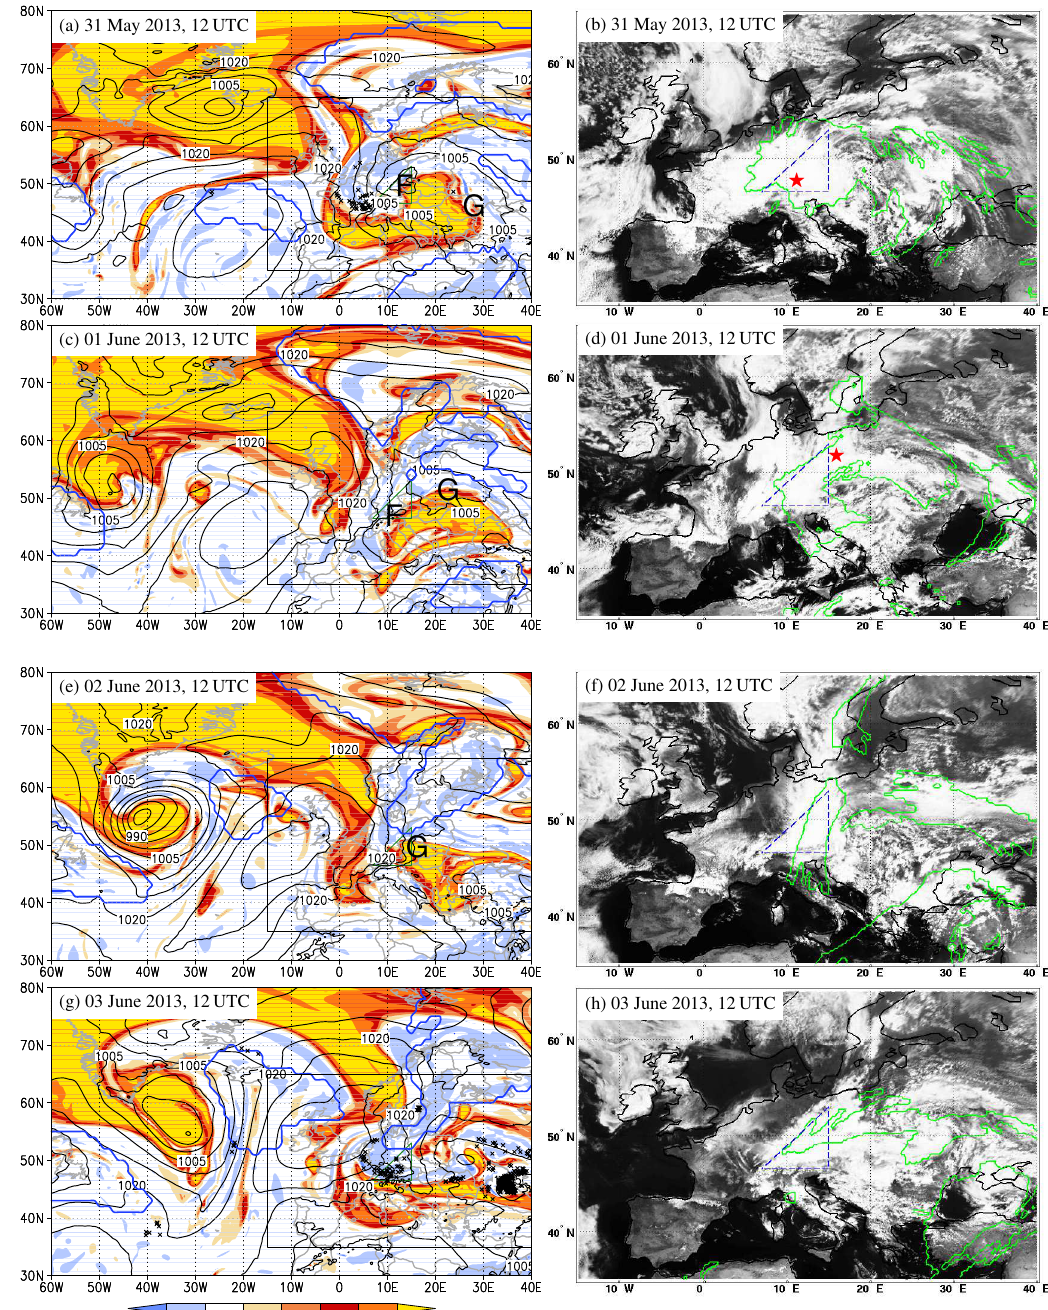
Figure 5. Left: PV at 320K (shaded in PVU), mean sea level pressure (black every 5hPa), outline of identified blockings (blue contour), and in (a–g) every 10th WCB trajectory intersection point with the layer 320K ± 2.5K. Only these WCBs are considered that contribute to the flooding event. The labels F and G mark the position of Frederik and Günther, respectively. Right: MSG-SEVIRI VIS 0.56–0.71µm satellite imagery zoomed over Europe (see box in left panels) and regions with precipitation from WCBs during the last 24h (green). The triangle (green on left, blue dashed on right) highlights the region affected by heavy precipitation (cf. Fig. 3a). The red star in b and d indicates the mean position of the WCB trajectories shown in Fig. 6a and b, respectively. (e–h) the same as in Fig. 5a–d except for 2 and 3 June